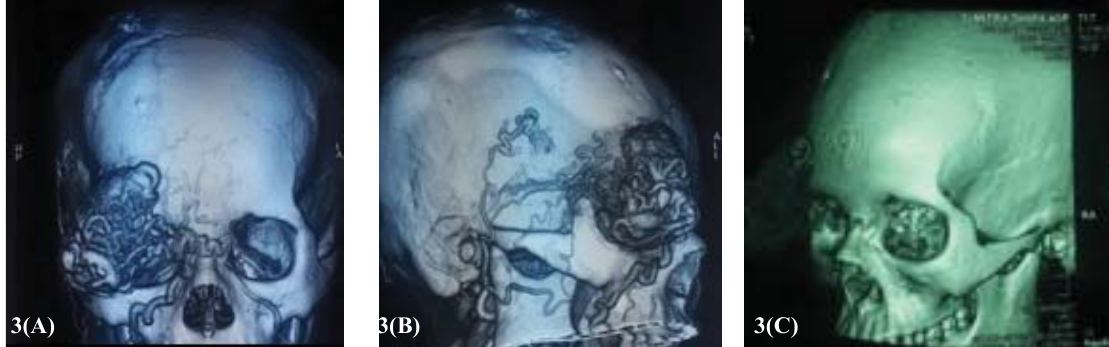
Figure 3. Three-dimensional CT angiography (3D-CTA) showing the giant right scalp-orbital AVM in relation to the skull and orbit (A) anterior, (B) lateral and (C) oblique views. Note the extension of lesion into the orbit without involvement skull bone and without